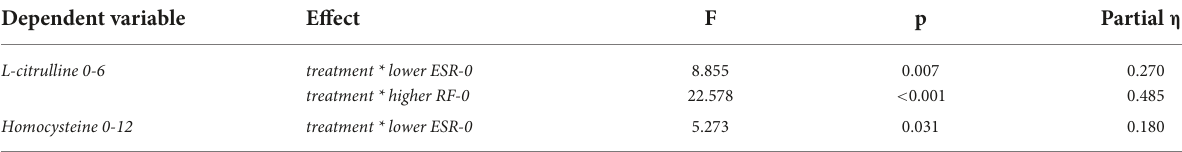
TABLE 3 Significant results of general linear model (GLM) repeated measures analysis of variance (RM-ANOVA) test determining the effects of treatment and other independent variables on 12-month changes in the levels of metabolites as dependent